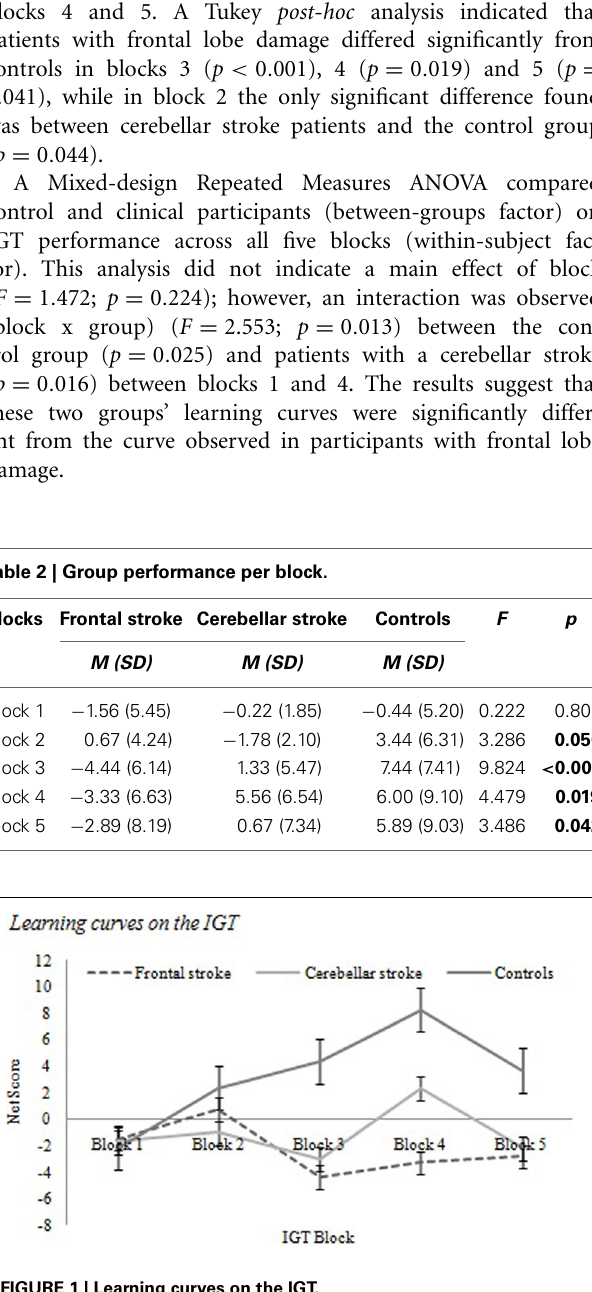
FIGURE 1 | Learning curves on the